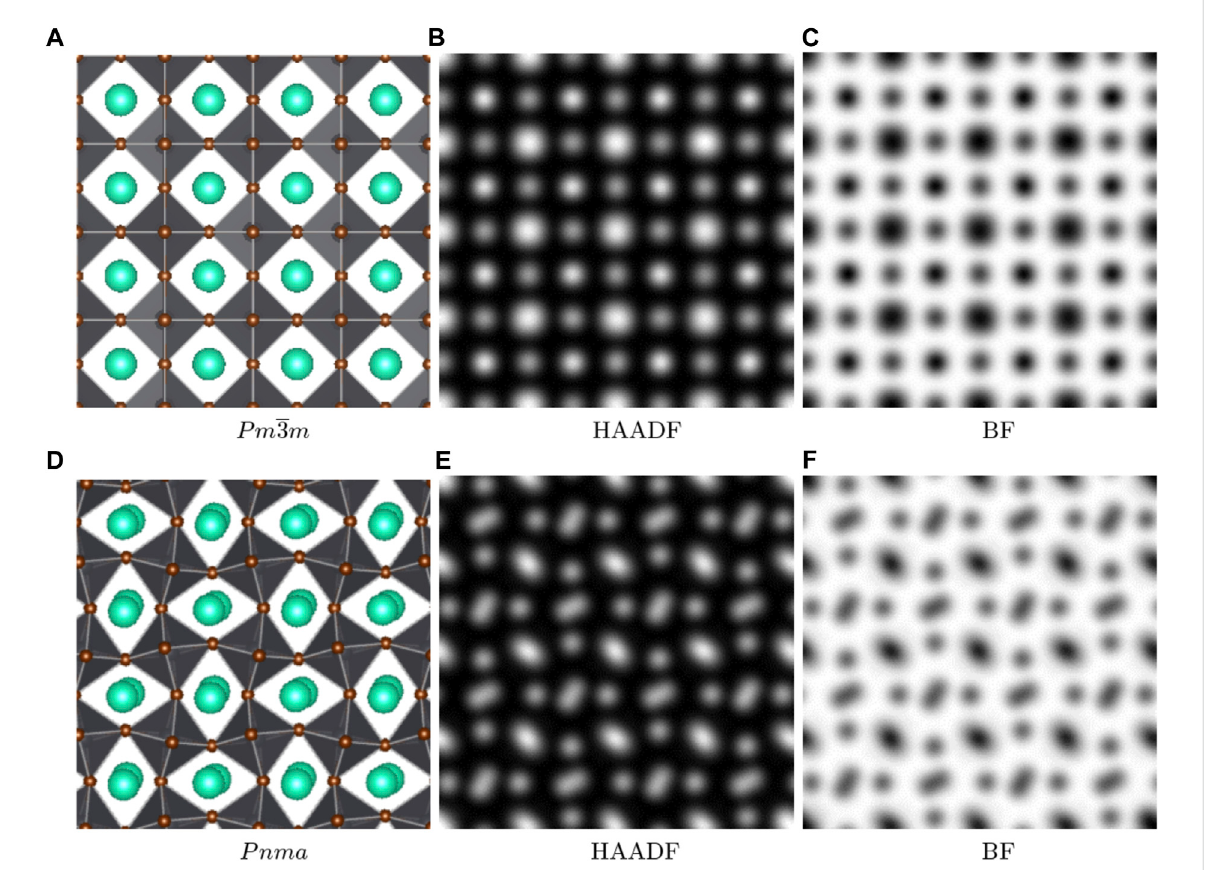
FIGURE 2 Scanning transmission electron microscopy, HAADF and bright fi eld (BF) simulations performed on the [001] direction of the cubic structure (A – C) and on the [010] direction of the orthorhombic structure (D – F) . Cs atoms are in green, Pb in the center of the octahedra in grey, and Br in